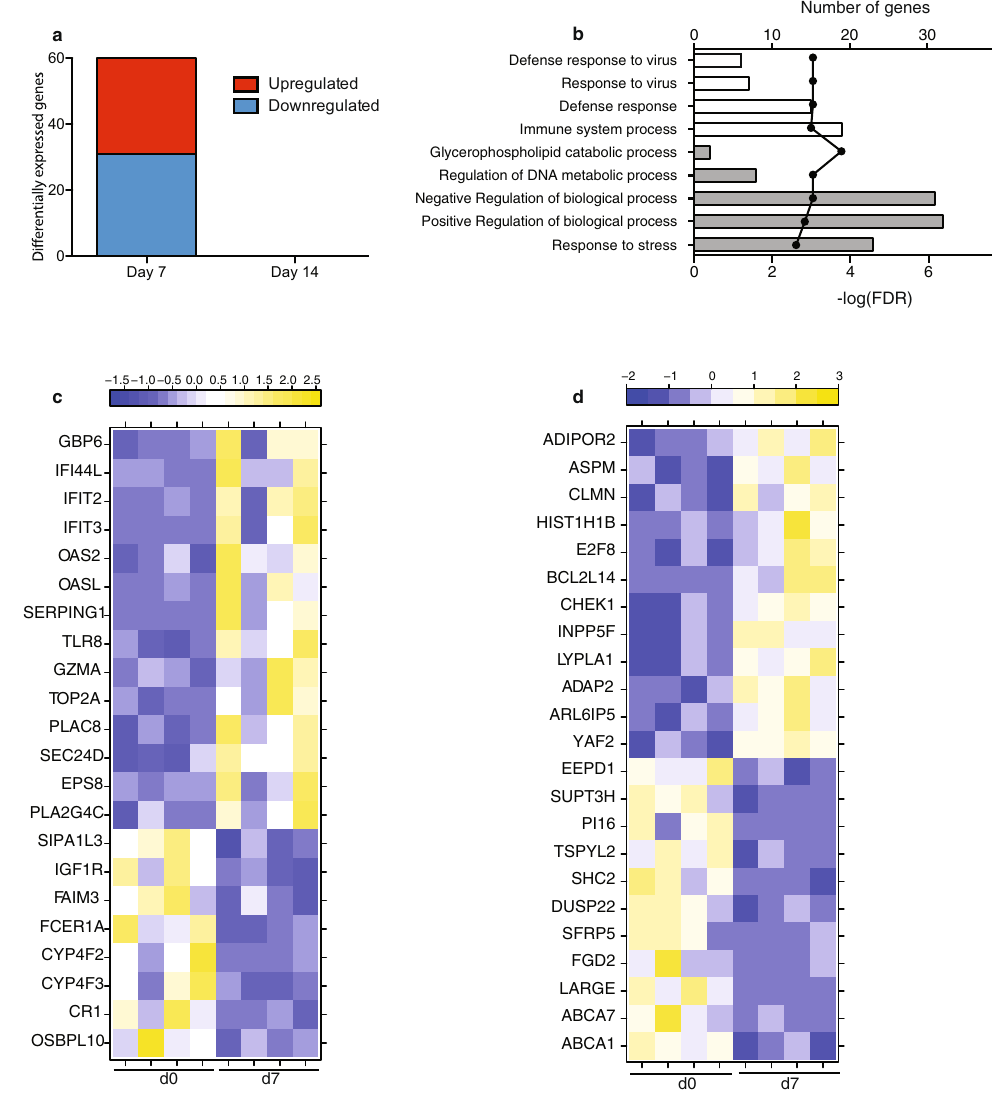
Figure 1. Vaccination with rVSV-EBOV induces expression of genes involved in innate immune response and cell cycle. ( a ) Number of differentially expressed genes (DEGs) defined as those with a fold change ≥ 2 and FDR corrected p-value ≤ 0.05; n = 4. ( b ) Bar graph depicting the most statistically significant Gene Ontology (GO) terms to which DEGs enriched; the line graph represents -log(FDR) of the enriched term. ( c ) Heatmap of all DEGs enriching to host defense GO terms (white bars) and biological process GO terms (grey bar); yellow represents increased expression while blue represents decreased expression; each column represents 1 animal. ( d ) Heatmap of all DEGs mapping exclusively to biological